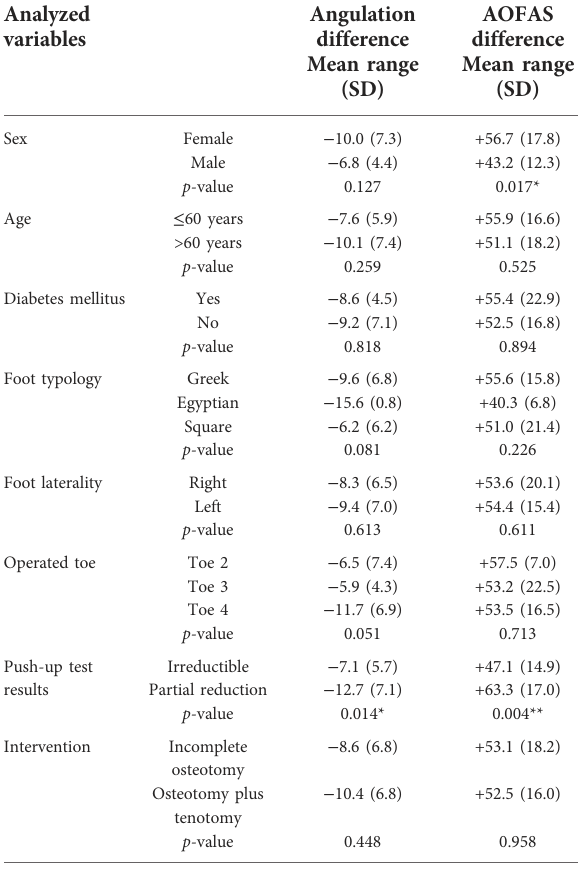
TABLE 2 Comparison of postoperative results according to patient pro fi les and characteristics of the injury and surgery. Analyzed